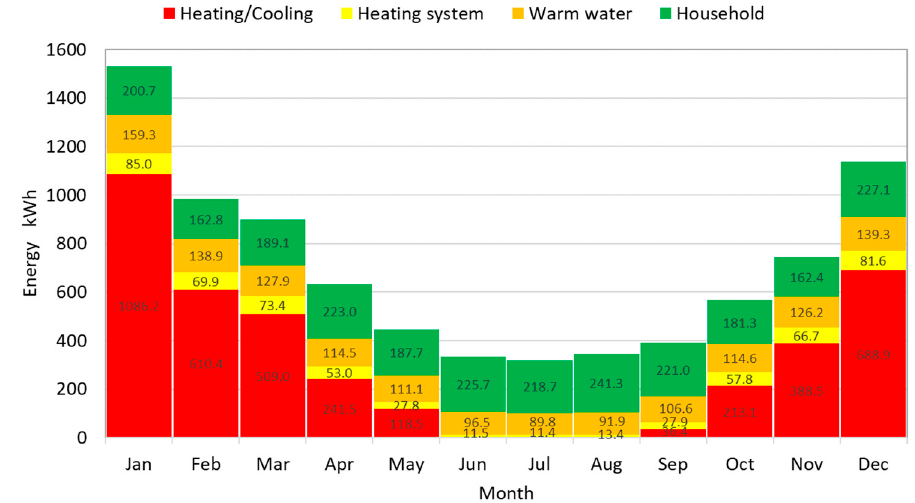
Figure 11. Structure of energy use in months in the building.